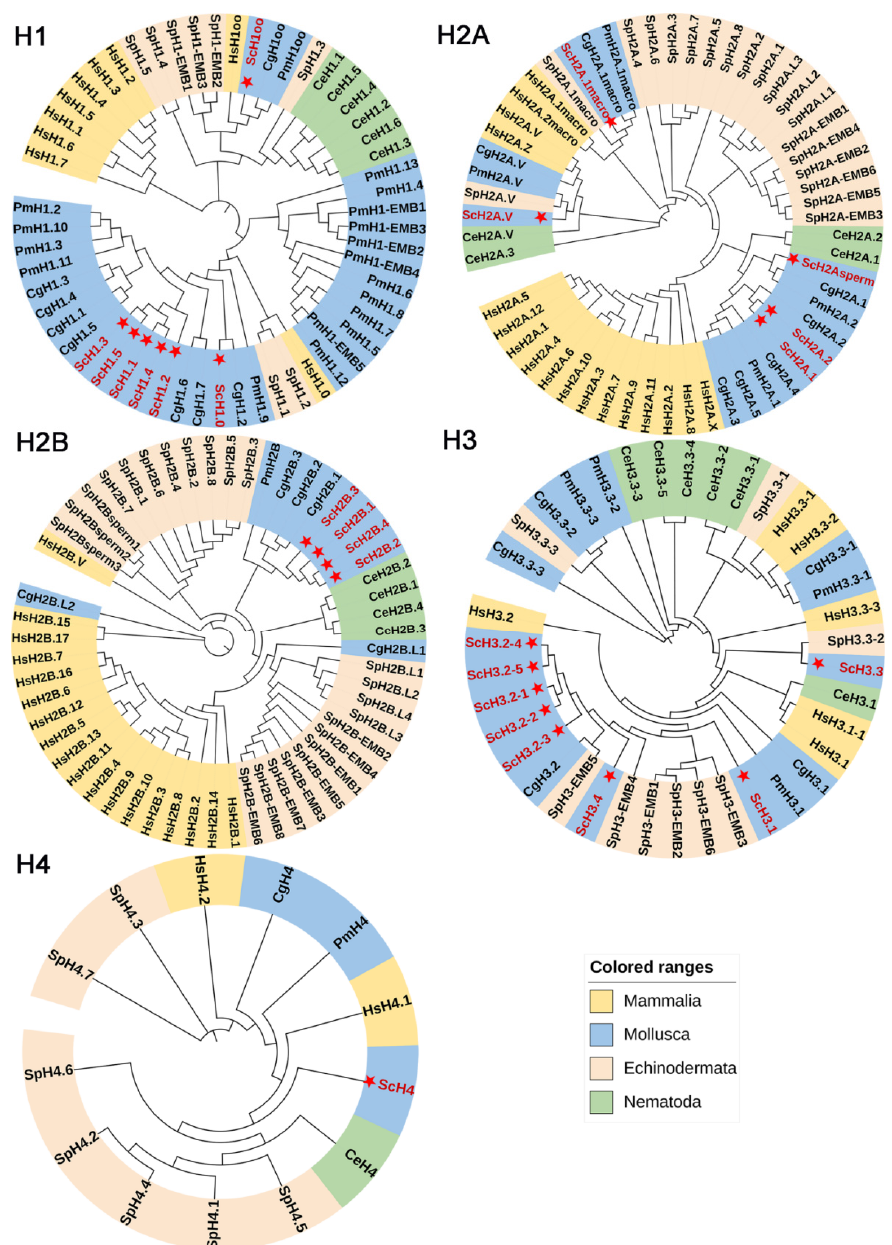
Figure 3. Phylogenetic analysis of the histone gene family in S. constricta and other species (see